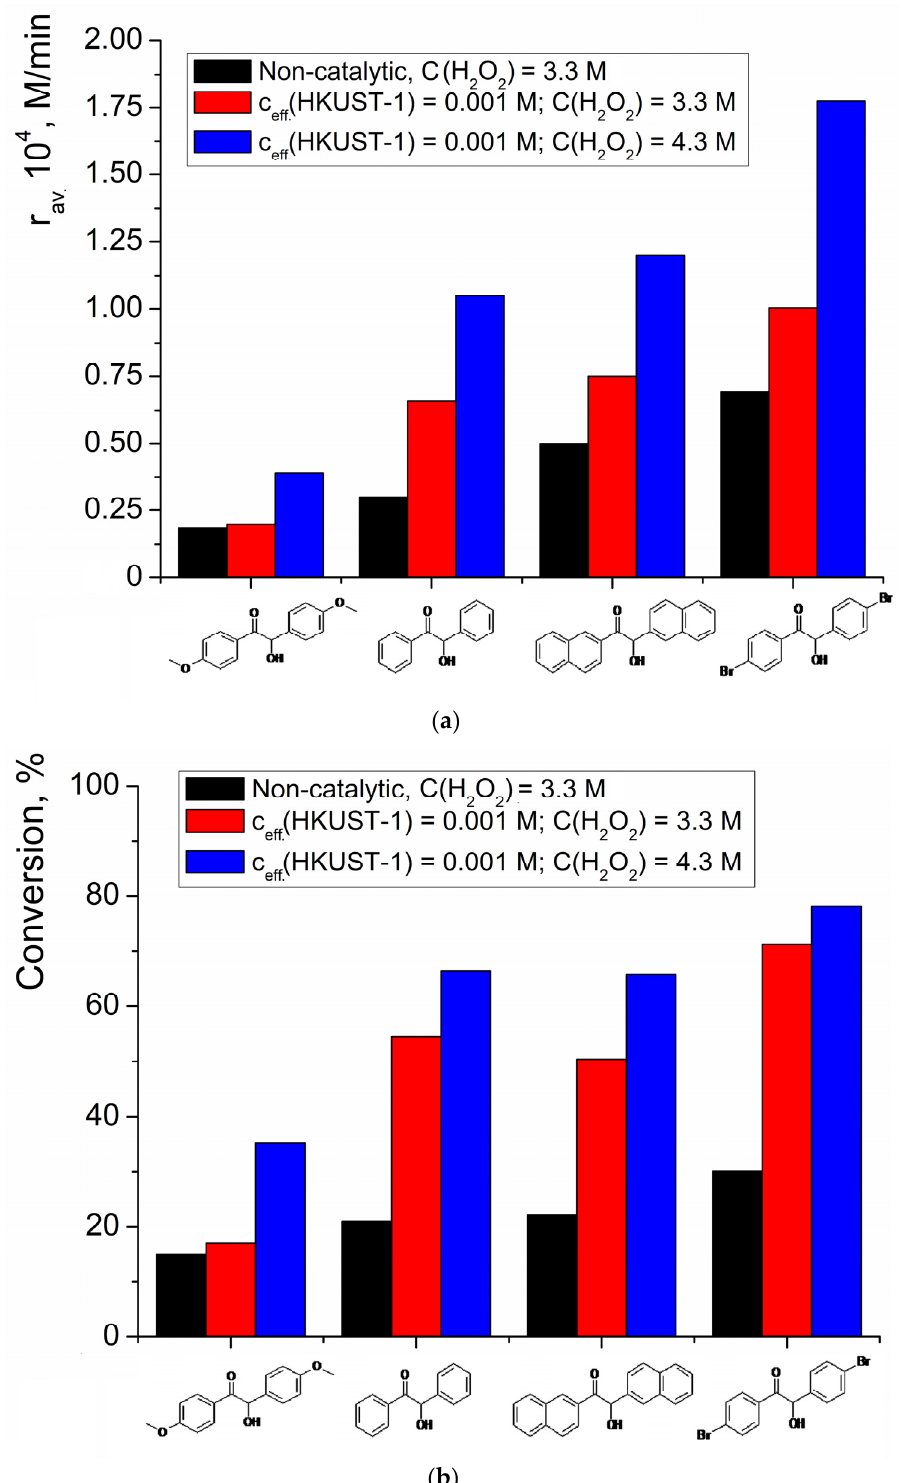
catalytic and non-catalytic reactions, were found for 4,4 (cid:48) -dibromobenzoin. The lowest values were observed for 4,4 (cid:48) -dimethoxybenzoin.